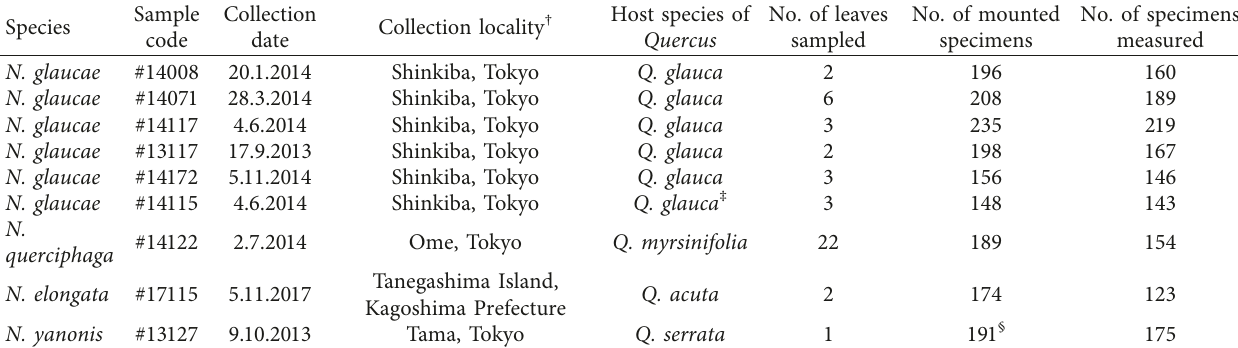
Table 1: Samples of Neothoracaphis species subjected to morphometric